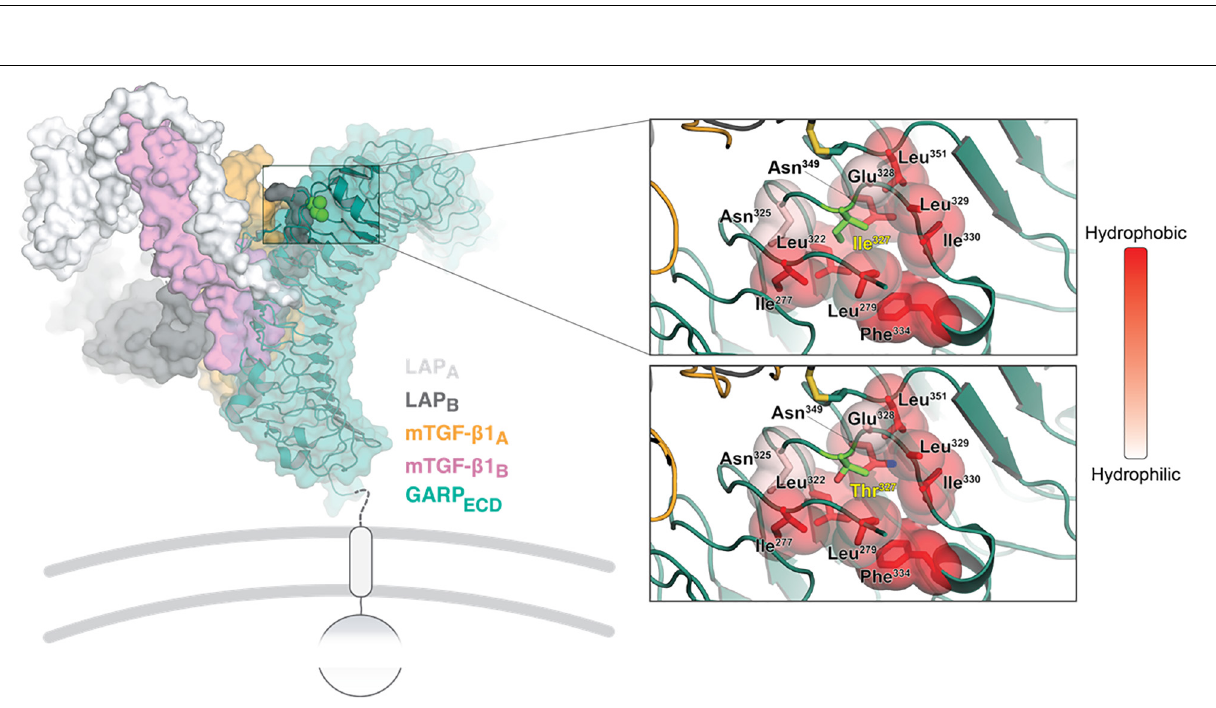
FIGURE 3 | Structural analysis of the GARP Ile327 > Thr mutation. On the left, an overview is shown of the crystal structure of GARP in complex with TGF- β 1 and stabilizing antibody MHG-8 Fab (PDB ID 6GFF). The top right close-up window shows the Ile327 site. The surrounding residues are colored in shades of red according to their hydrophobicity (right bar). The same site is shown with the Ile327 substitute and with a Thr residue right bottom). The local backbone and surrounding residues were energy minimized using the PyMol build